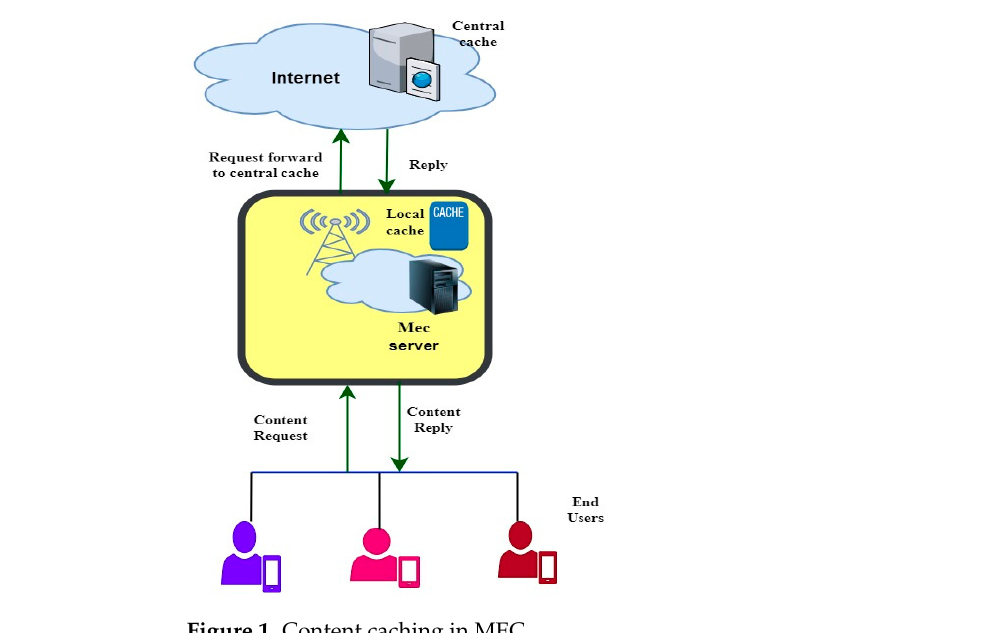
Figure 1. Content caching in MEC.